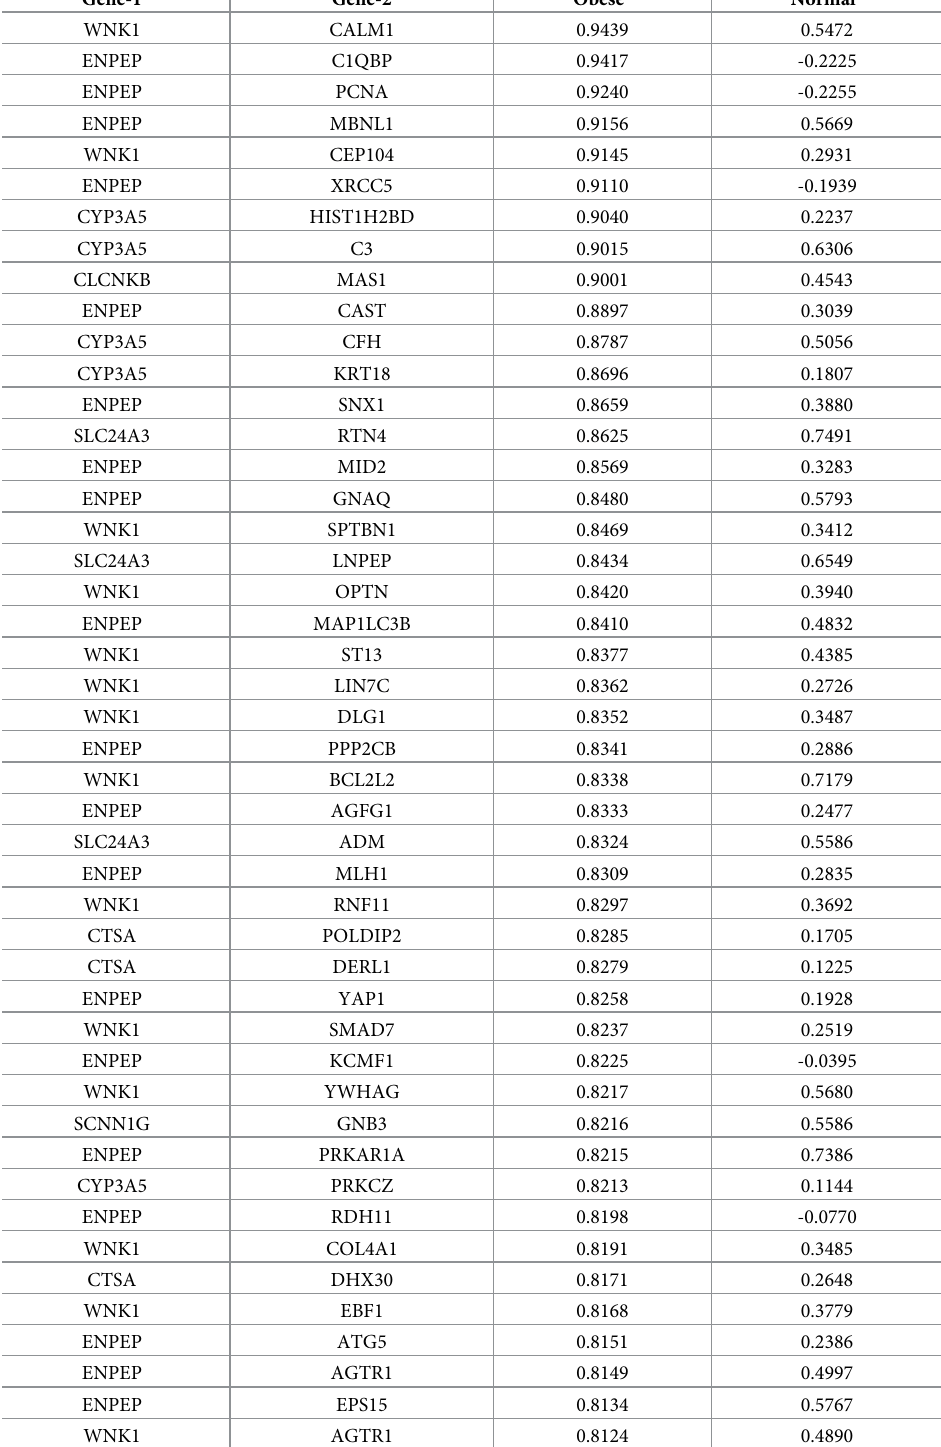
Table 6. Interactions of unreported salt sensitive genes in obese and normal condition with their corresponding co-relation score as